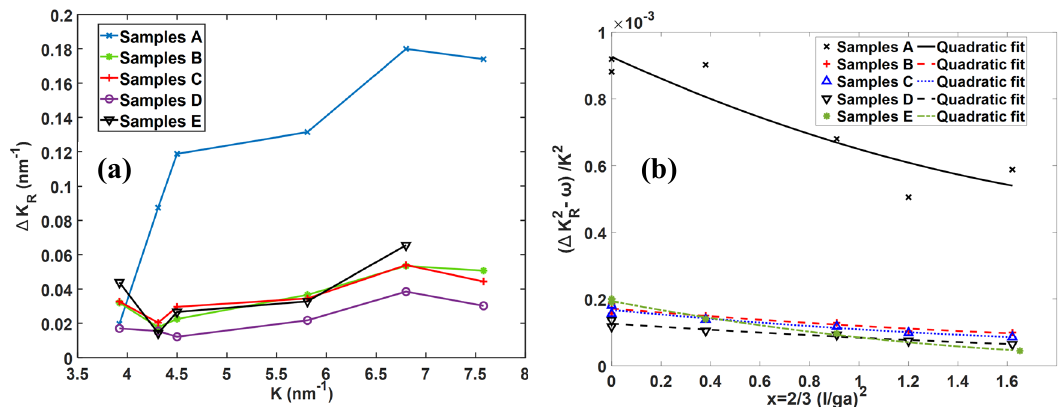
Figure 11. ( a ) The resulting FWHM values of the peaks obtained after convolution of Gaussian and Lorentzian functions in Equation (12) against diffraction vector ( K ) for the five types of DMLS Ti6Al4V (ELI) samples and ( b ) the relationship between (∆ K 2 − ω)/ K 2 and x for various samples of DMLS Ti6Al4V. Table 2. The measured value of parameters q 1( m ) and q 2( m ) .